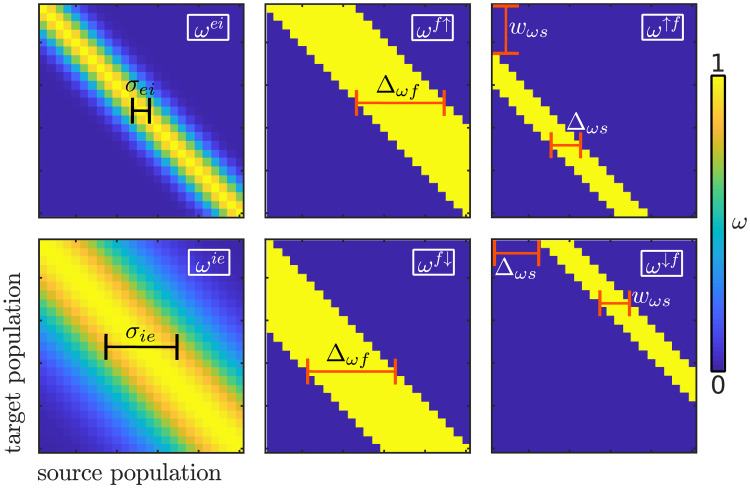
Connectivity matrices.Matrices show the connection between the first 25 ensembles of each source-target group. From left to right, matrices correspond to: excitatory-to-inhibitory ωei, inhibitory-to-excitatory ωie; bottom-up AMPA connections spectral-to-up ωf↑, spectral-to-down ωf↑; and feedback NMDA connections up-to-spectral ω↑f, down-to-spectral ω↓
f. Labels are encircled in a white square in the top right of each plot. The free parameters of each connectivity matrix are defined geometrically in the plots.